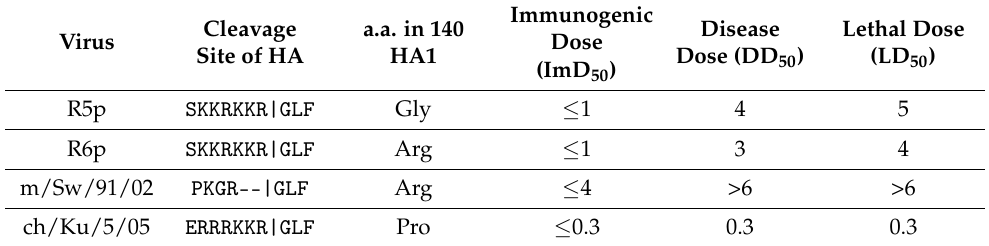
Table 3. Effect of Gly140Arg amino acid substitution in HA1 on pathogenicity in mice.